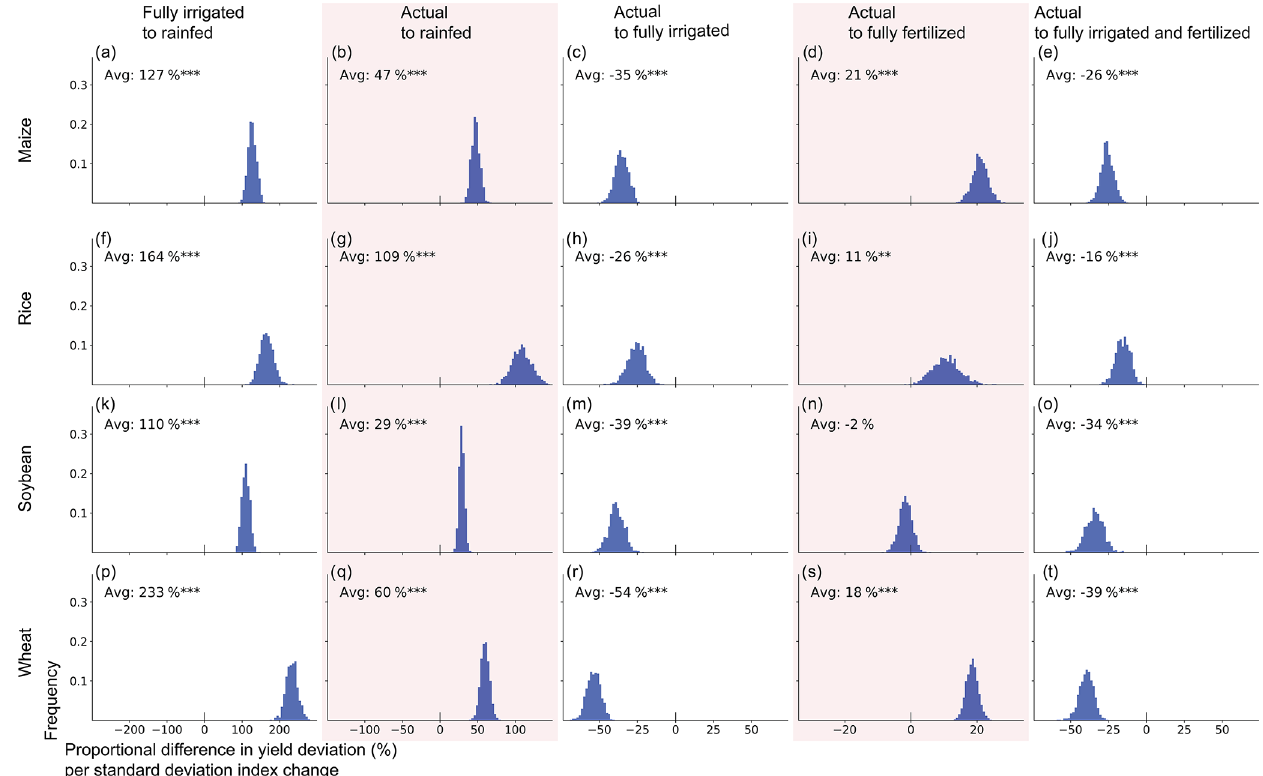
Figure 4. Relative average difference in sensitivity magnitude of maize (a–e) , rice (f–j) , soybean (k–o) , and wheat (p–t) between a range of cropping scenarios through all the studied oscillations and FPUs. To quantify how the impacts in these cropping systems vary, average sensitivity magnitudes were compared for each crop. Specifically, for a pair of scenarios, the average difference of their absolute sensitivity values was calculated across all oscillations and FPUs, with at least one scenario showing a significant sensitivity. To obtain a measure relative to the actual (or irrigated when comparing irrigated and rainfed scenarios) scenario, the average difference values were divided with the average sensitivity magnitude of the actual (irrigated) scenario for the FPUs included. For each crop, to assess whether the mean sensitivity magnitude difference is statistically significantly different from zero, a distribution of the mean difference was created by calculating the average from the bootstrapped ( N = 1000, with replacement) difference values of each FPU and oscillation. For the scenarios with varying fertiliser use set-up, we included only the nine GGCMs which have data for both the fullharm and harm-suffN settings and also simulate nutrient stress, i.e. pDSSAT, EPIC-Boku, EPIC-IIASA, GEPIC, pAPSIM, PEGASUS, EPIC-TAMU, ORCHIDEE-crop, and PEPIC. Triple, double, and single asterisks denote the confidence level at 99.9%, 99%, and 90%, respectively. Maps of sensitivity for each cropping system are shown in Figs. S14–S18 and differences in sensitivity magnitude in Figs. S19–S23. Please note the different scale in the x axis between the